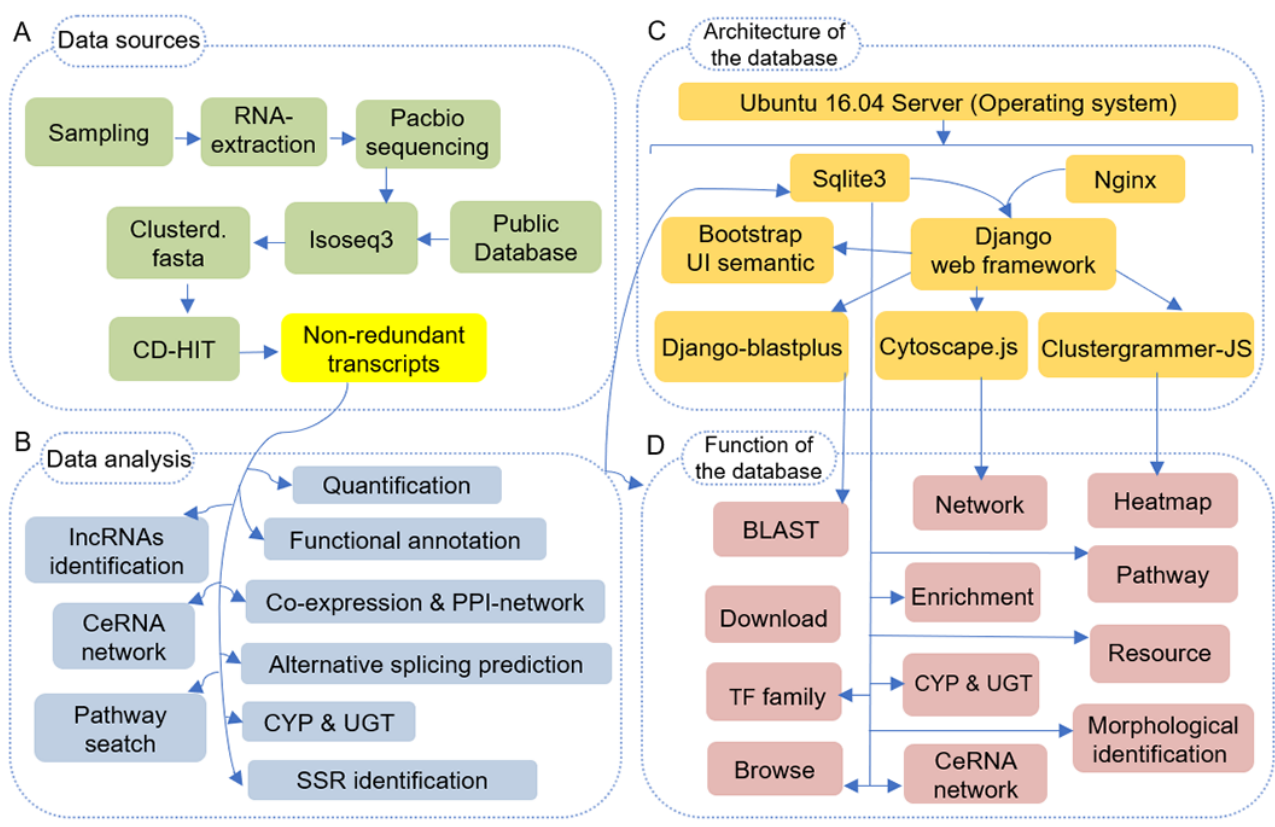
Figure 1. Implementation of PPDP. ( A ) RNA ‐ Seq of sampled tissues and data pre ‐ processing. ( B ) The main data analysis process. ( C ) The basic architecture of PPDP. ( D ) The main functions and related tools of PPDP.